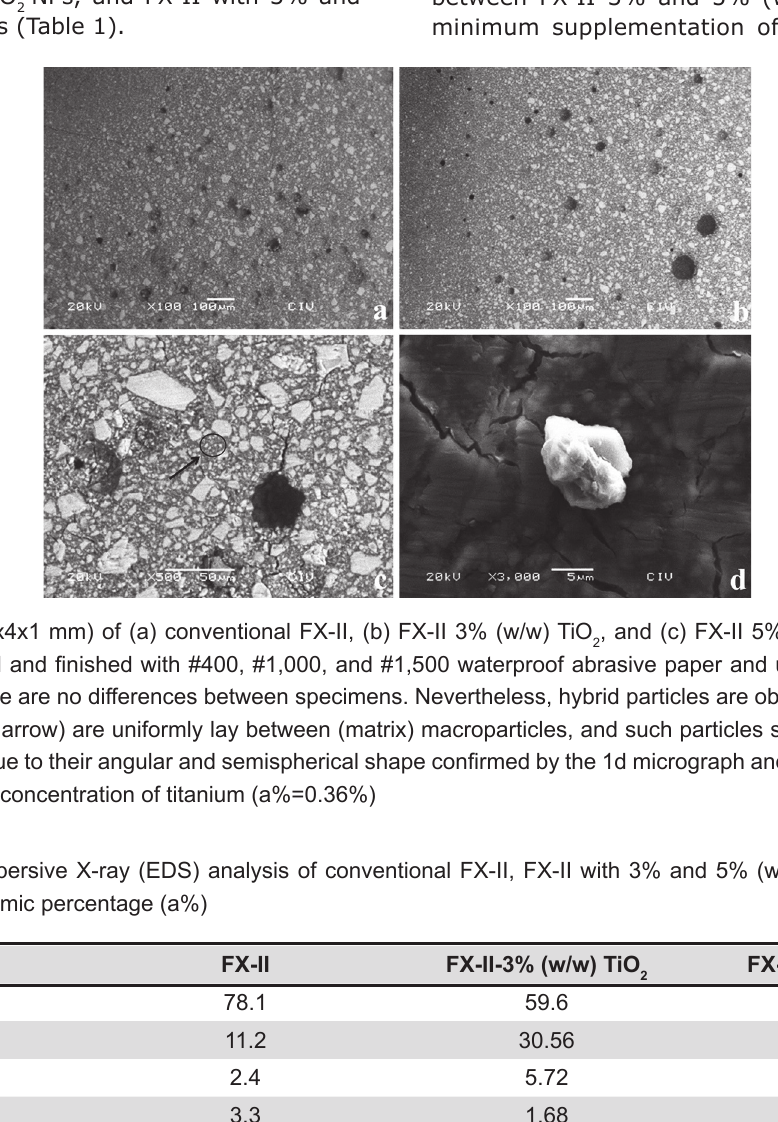
FX-II: Enhanced restorative cement TiO : Titanium dioxide nanopowder 2